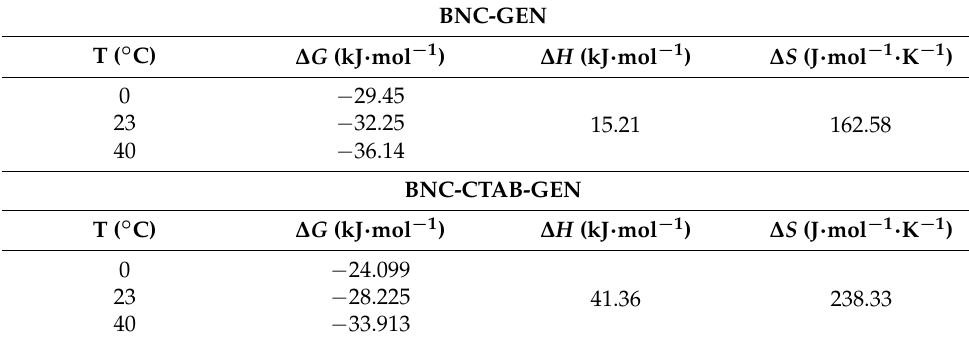
Table 2. Thermodynamic results for BNC-GEN and